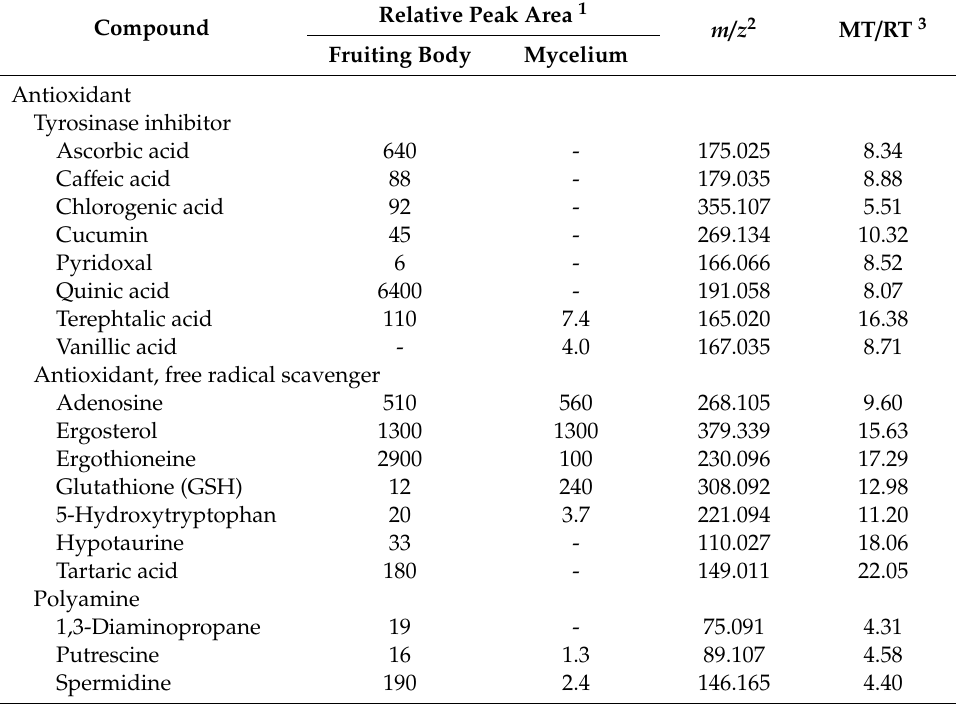
Table 1. Putative metabolites for the natural polyphenol oxidase inhibitors in H. erinaceus fruiting body and mycelium.